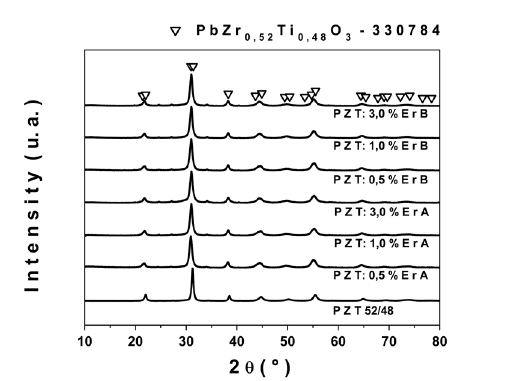
Figure 3. X-ray diffraction patterns of the precursors prepared at 700 °C with different Er concentration. In following, microscopy analysis were carried out in all powder precursors. The images were made in SEM-FEG and TEM microscopes. The micrographs revealed that the particles are nanometric size and form agglomerated during calcination stage, as can to be seen in Figures 4a, 4b, 5a and 5b. In our opinion, the agglomerates of particles are due to coalescence